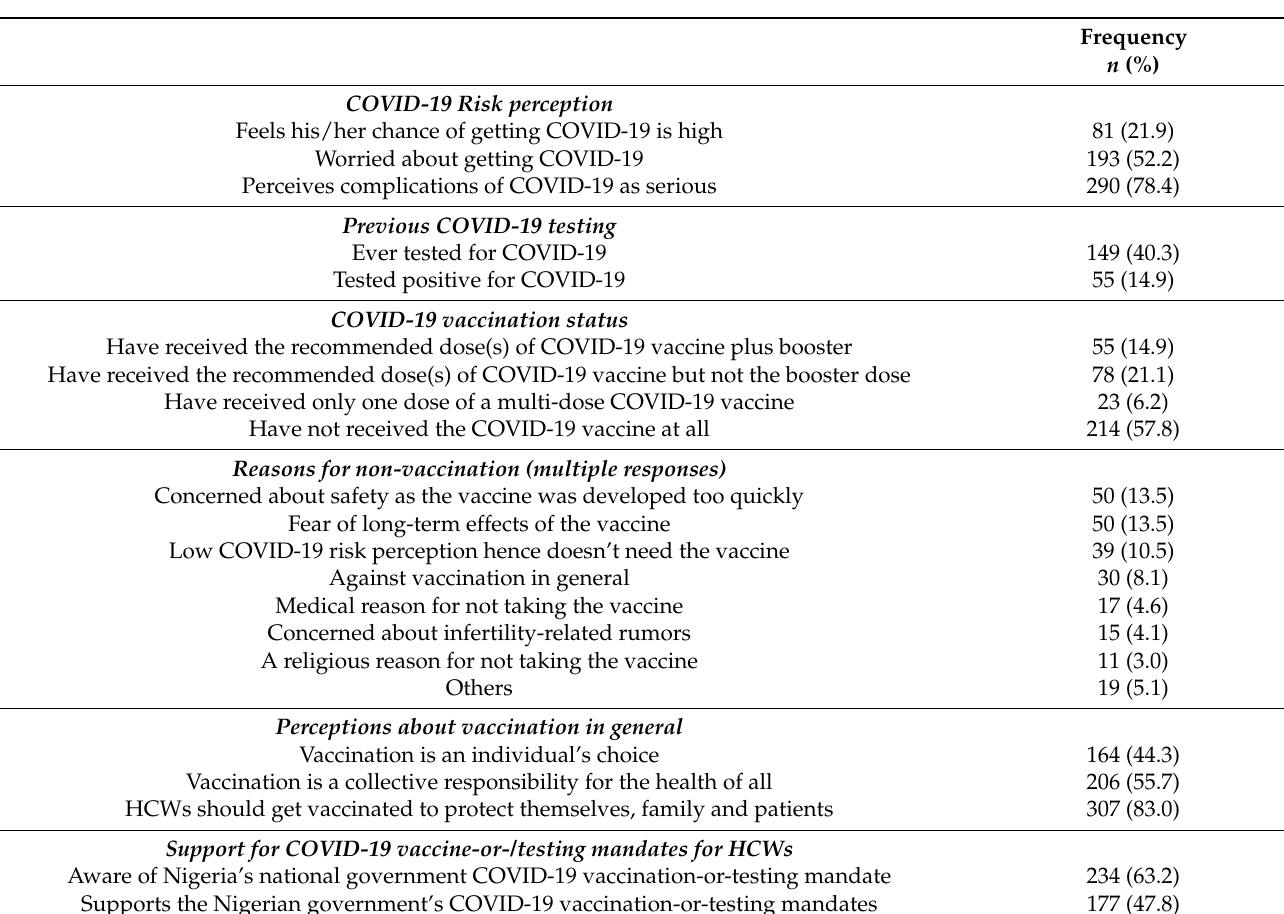
Table 2. COVID 19-risk perception, vaccination, and testing ( N =